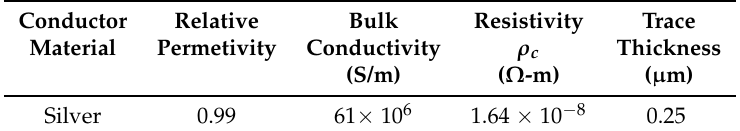
Table 1. Properties of the conductor used in the coil.